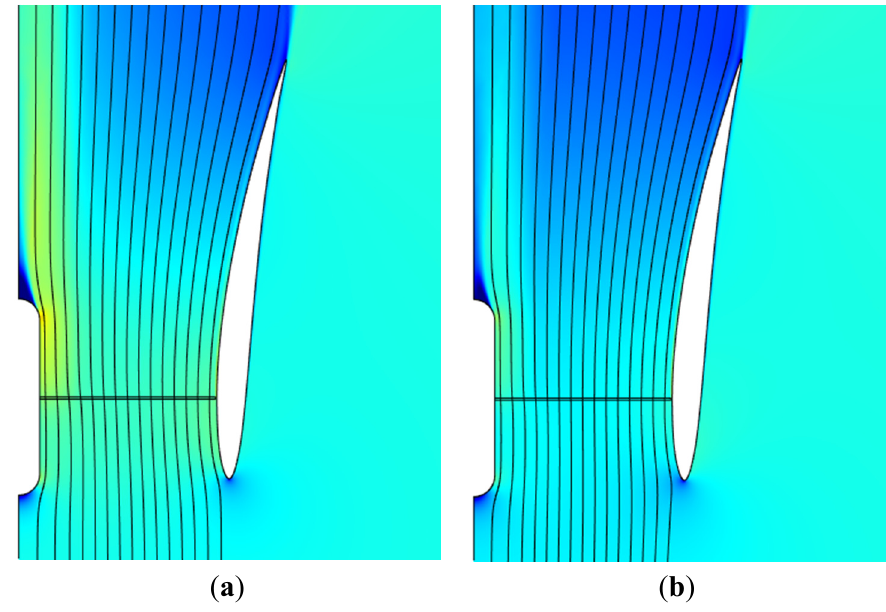
Figure 18. Axial velocity and streamlines. C DAWT. Nacelle/rotor: Centerbody with cylindrical root